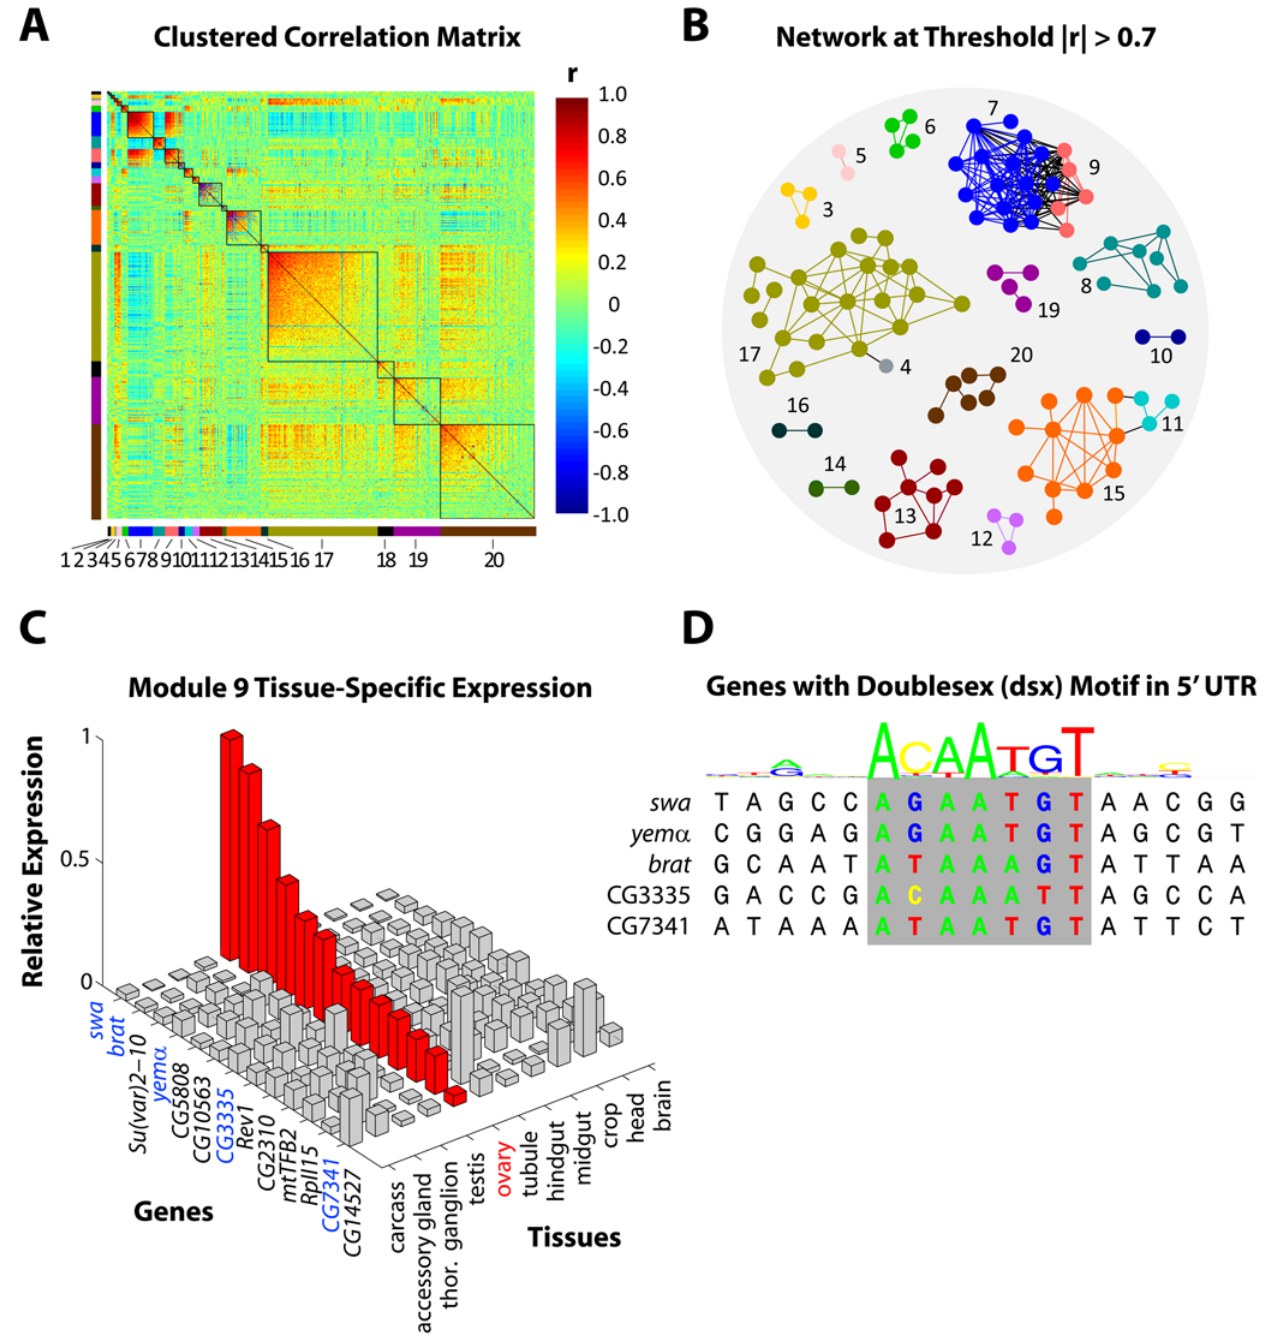
Figure 5. MMC analysis of Drosophilamelanogaster data. Panels (A)–(D) describe a systems genetic analysis of 414 Drosophila melanogaster genes associated with a competitive fitness phenotype. (A) The reordered matrix of pairwise genetic correlations between transcriptional profiles, in analogy to Figure 3F. The twenty clusters identified by MMC are numbered (Modules 1–20), color-coded (to the left and below), and emphasized with borders. From the upper left (Module 1) to lower right (Module 20), modules are ordered by decreasing average connectivity, defined here as average absolute pairwise correlation within the module. (B) Relevance network obtained from the 414 genes by enforcing an absolute correlation threshold of r j j w 0 : 7 . The genes are numbered and color-coded as in (A) to indicate module membership. Only genes with at least one connection are shown. (C) Bar chart of the genes in Module 9 reporting for each one its relative expression level across eleven tissues. Genes are shown on the x -axis, tissues are shown on the y -axis, and relative expression is shown on the z -axis. Expression in the ovary has been highlighted in red, and the genes featured in the next panel have been highlighted in blue. (D) Local alignment of five genes sharing the dsx motif in their 5 9 UTRs. Above the alignment, a logo is shown to represent the profile of the 17 bp recognition sequence of doublesex .